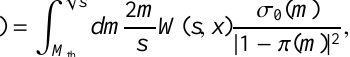
X i , and ISR process (b) e + e − →